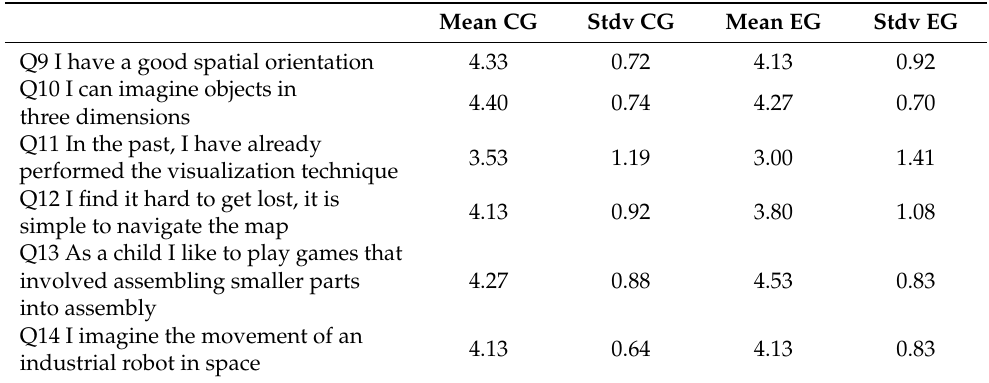
Table 3. Students spatial orientation evaluation.